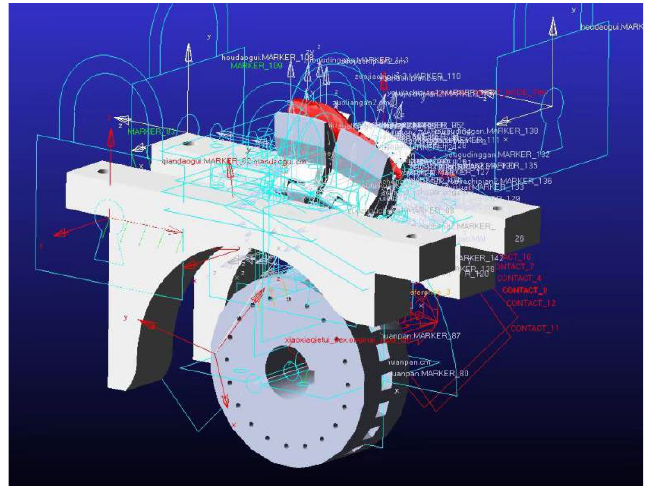
Figure 16. Simulation